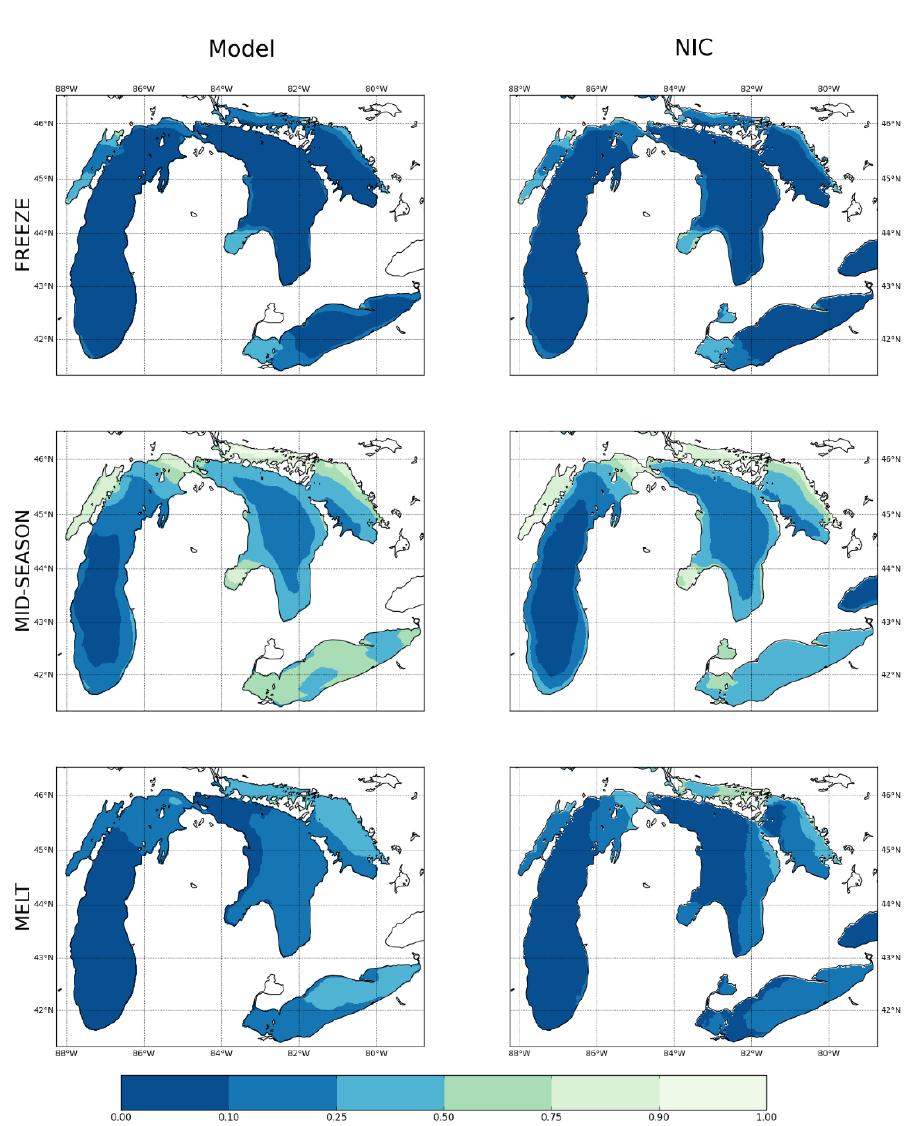
Figure 2. Spatial pattern of ice concentration (0–1) for freezing (1 December–15 January), mid-season (16 January–15 March), and melting (15 March–1 May) seasons. Averaging is performed for each season from 2015–2017. Left column shows the model results from LEOFS and LMHOFS, and right column shows the NIC analysis.